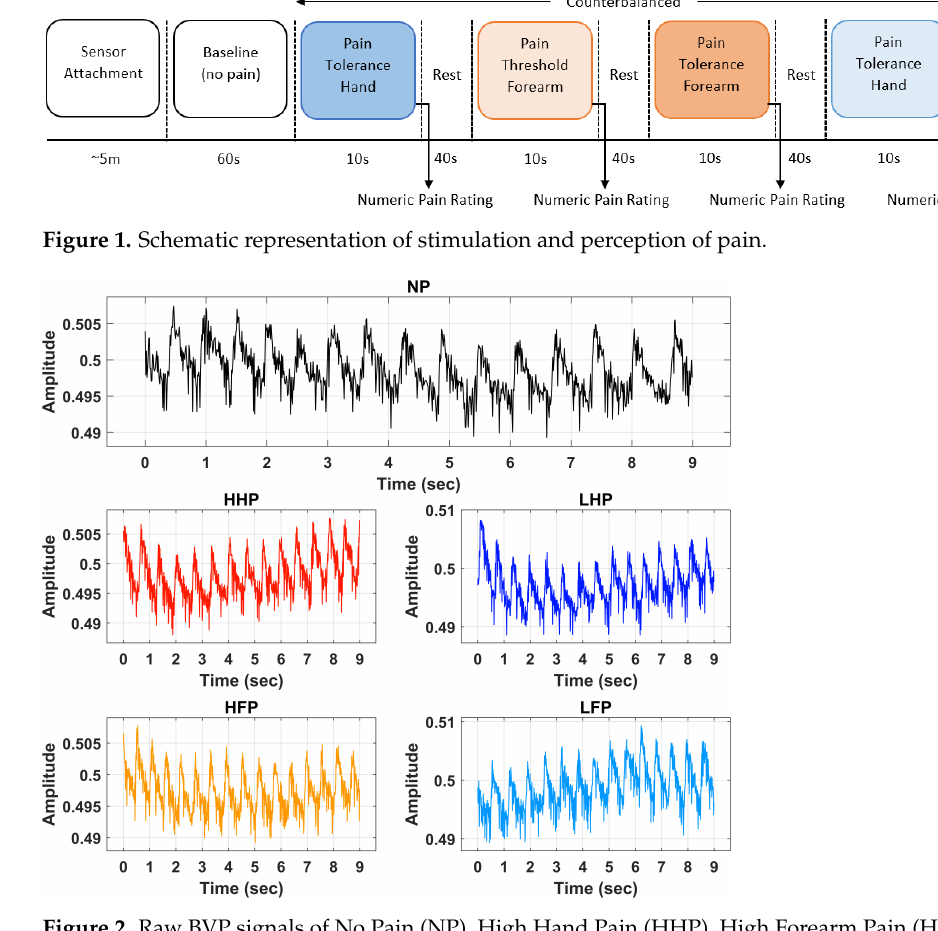
Figure 2. Raw BVP signals of No Pain (NP), High Hand Pain (HHP), High Forearm Pain (HFP), Low Hand Pain (LHP), and Low Forearm Pain